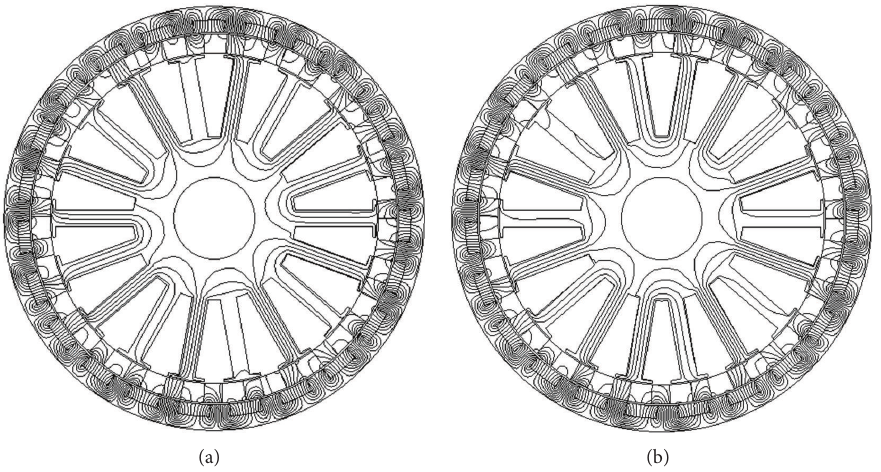
Figure 2: Magnetic field distributions: (a) no-load and (b)